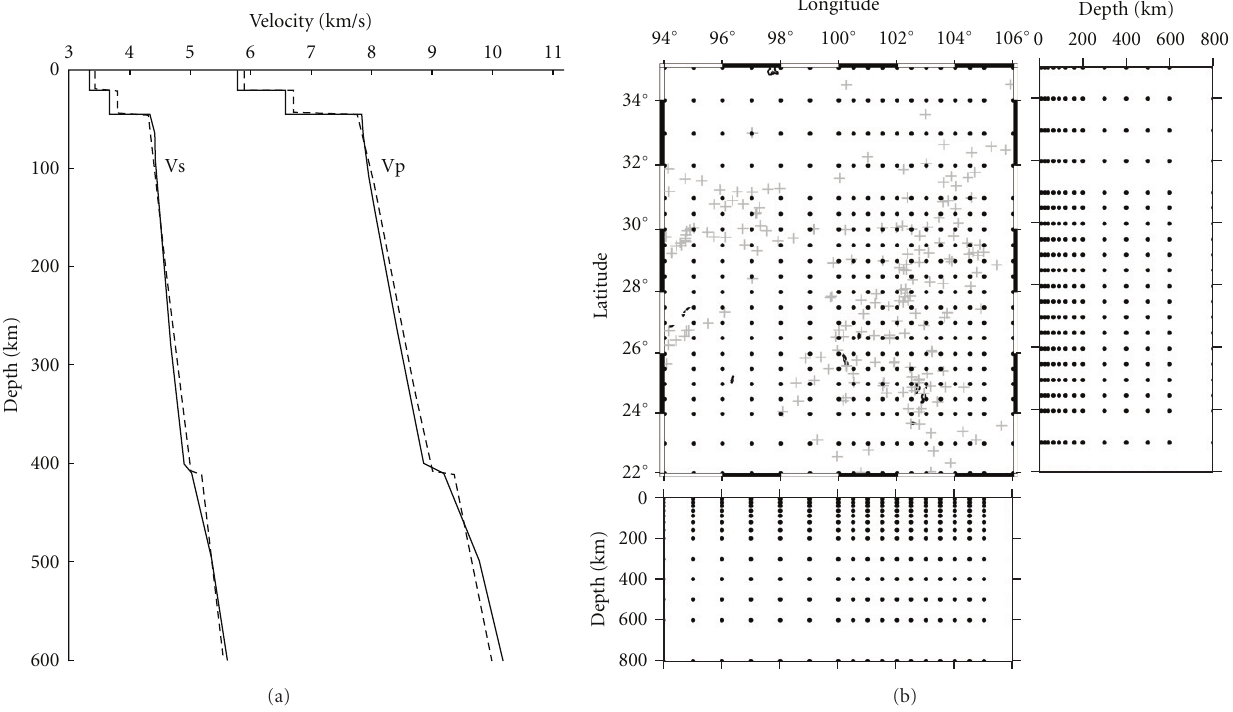
Figure 3: (a) 1D velocity models. The solid lines show the optimal V p and V s velocity models used in this study. The short dashed lines indicate the initial velocity model inferred from the previous tomographic and receiver function studies [5, 16] and the IASP91 model [17]. (b) The grid model adopted for the final tomographic inversion. The grid spacing is 50–100 km in N-S and E-W directions and 10–200 km in depth. Gray crosses denote the seismic stations. In areas with more seismic stations, a smaller grid spacing is